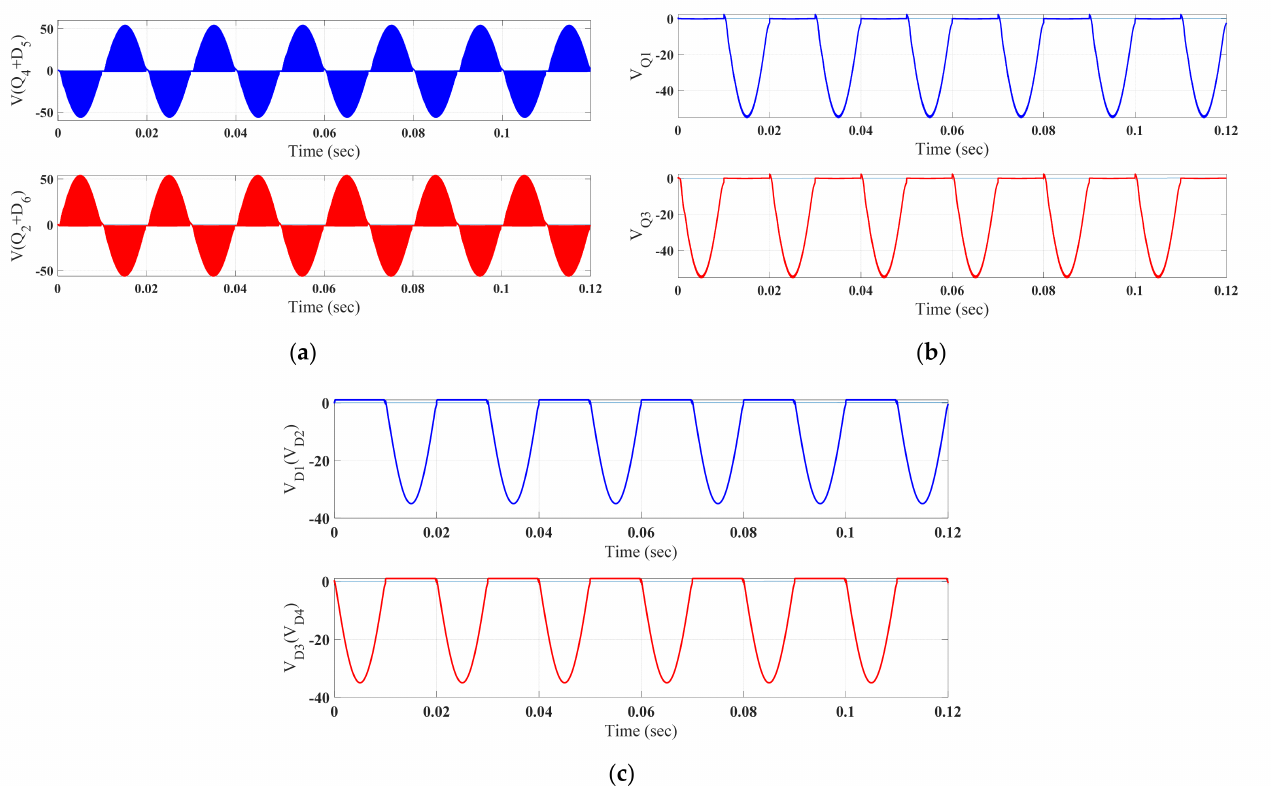
Figure 11. Simulated voltage waveforms developed across the semiconductor devices: ( a ) Q 4 , D 5 (blue) and Q 4 , D 5 (red); ( b ) Q 1 (blue) and Q 3 (red); ( c ) D 1 , D 2 (blue) and Q 3 , D 4 (red).